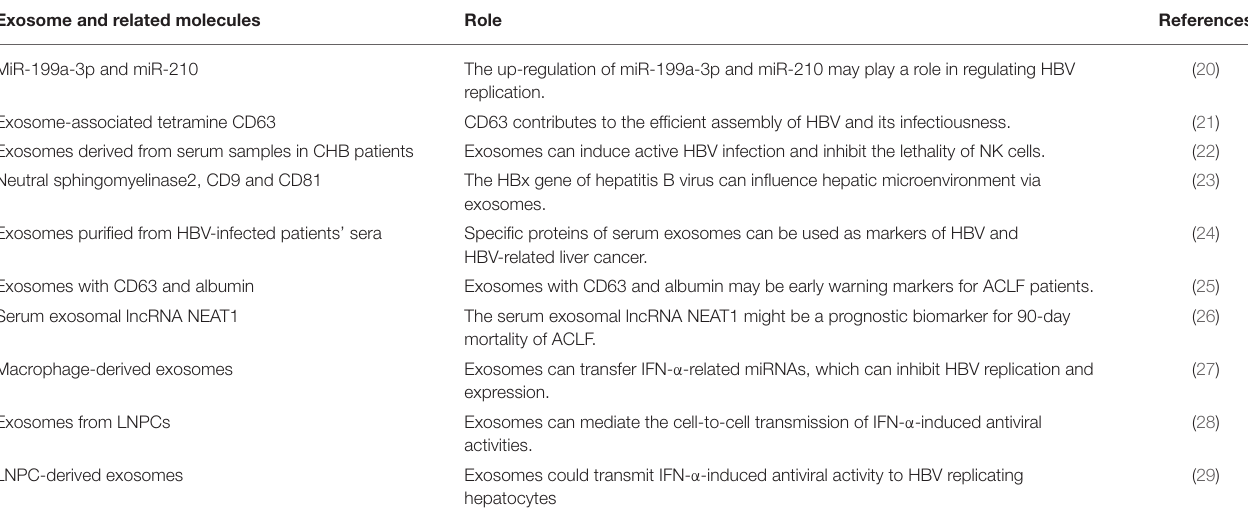
TABLE 1 | The role of exosomes in hepatitis